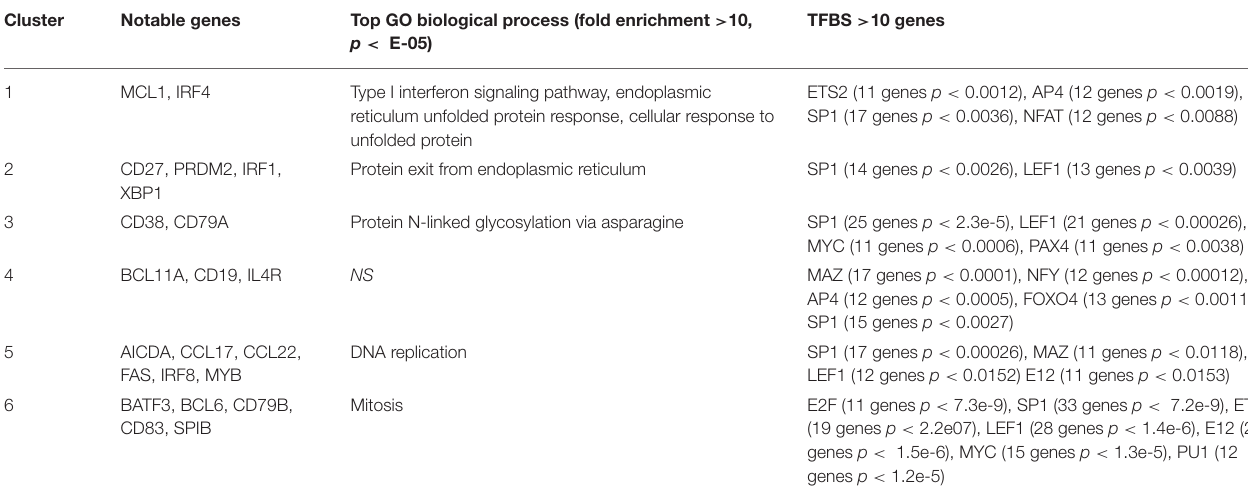
TABLE 1 | Summary of temporal clusters. Cluster